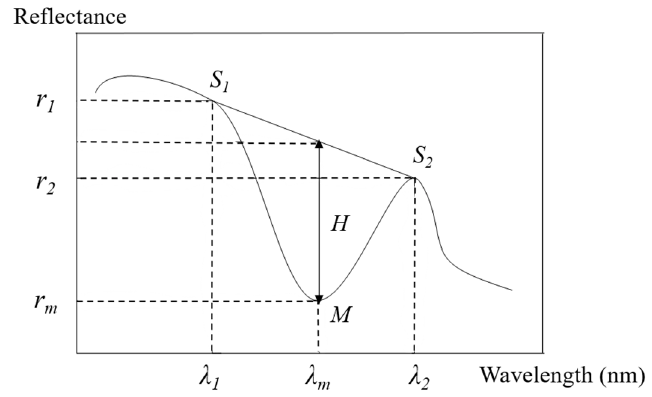
Figure 5. Parameters of Spectral Absorption Index.